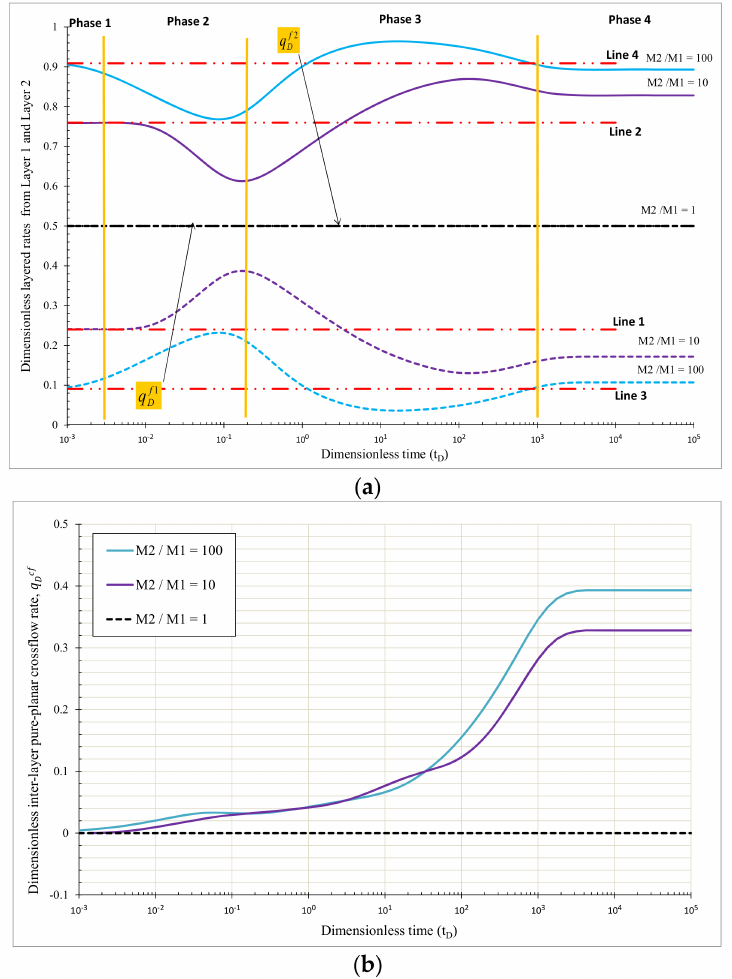
Figure 11. ( a ) Production rates of fractures in Layer 1, q f 1 , and in Layer 2, q f 2 , and ( b ) inter-layer D D L f 1 D = 2 L f 2 D = 0.98, h = h = 5, pure-planar crossflow rate q cf , under various M 2 /M 1 ratios with 2 f 1 D f 2 D x e 1 D = x e 2 D D N stage = 10; x e 1 D = x e 2 D = 100, y e 1 D = y e 2 D = 100, h e 1 D = h e 2 D = 50 and C s2 /C s1 = 1. For the case M 2 /M 1 = 1, the dimensionless fracture rate of each layer sums to 0.5 and inter-layer pure-planar crossflow rate equals 0 because this case equivalently accounts for a homogeneous reservoir and the two layers are identical in both geometry and